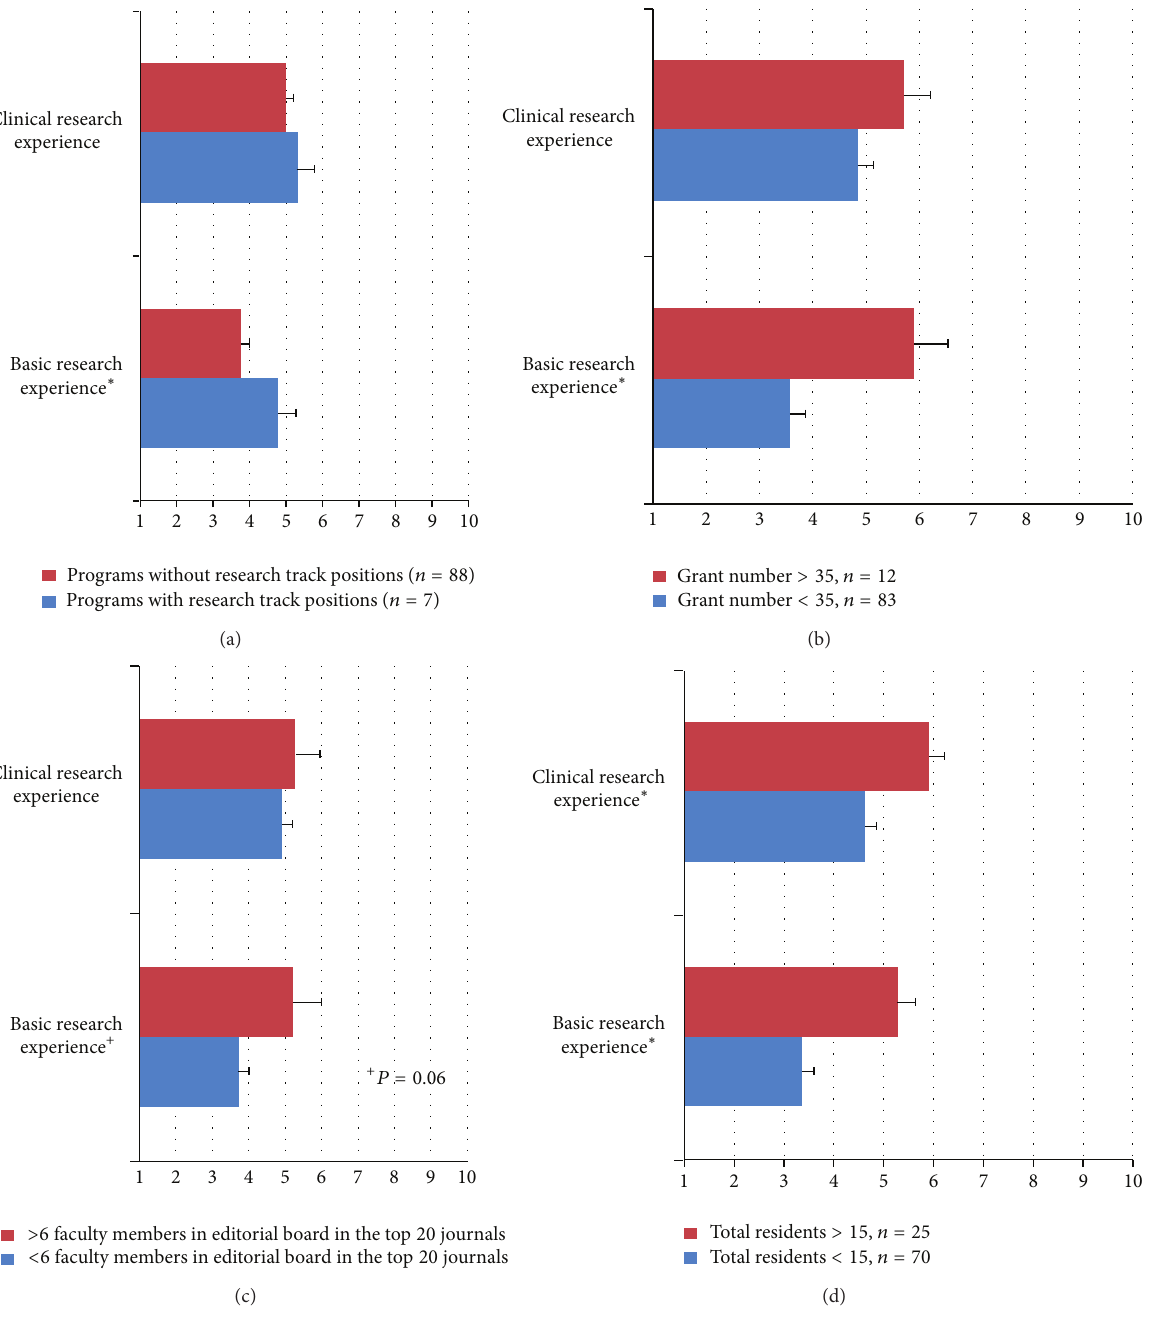
Figure 3: The differences in PD’s attitude regarding the importance of basic and clinical research fellowship prior to beginning residency are shown. The results have been illustrated based on programs offering a research track position (a), number of grants (b), number of faculty members on the editorial board in top dermatology journals (c), and number of residents (d). ∗ The comparisons with an asterisks reached to a statistical